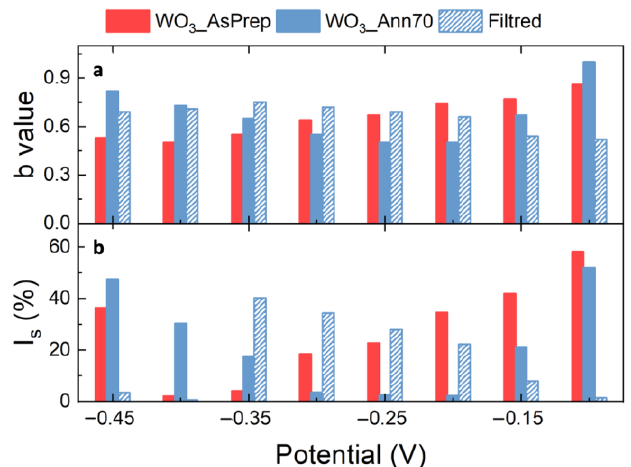
Figure 4. Comparison of ( a ) b values and ( b ) of surface-limited current contributions (I s ) obtained for NF WO 3 _AsPrep and WO 3 _Ann70 and F WO 3 _Ann70 pastes electrodes and as a function of applied potential at 5 mV/s. The potential is measured versus SCE.